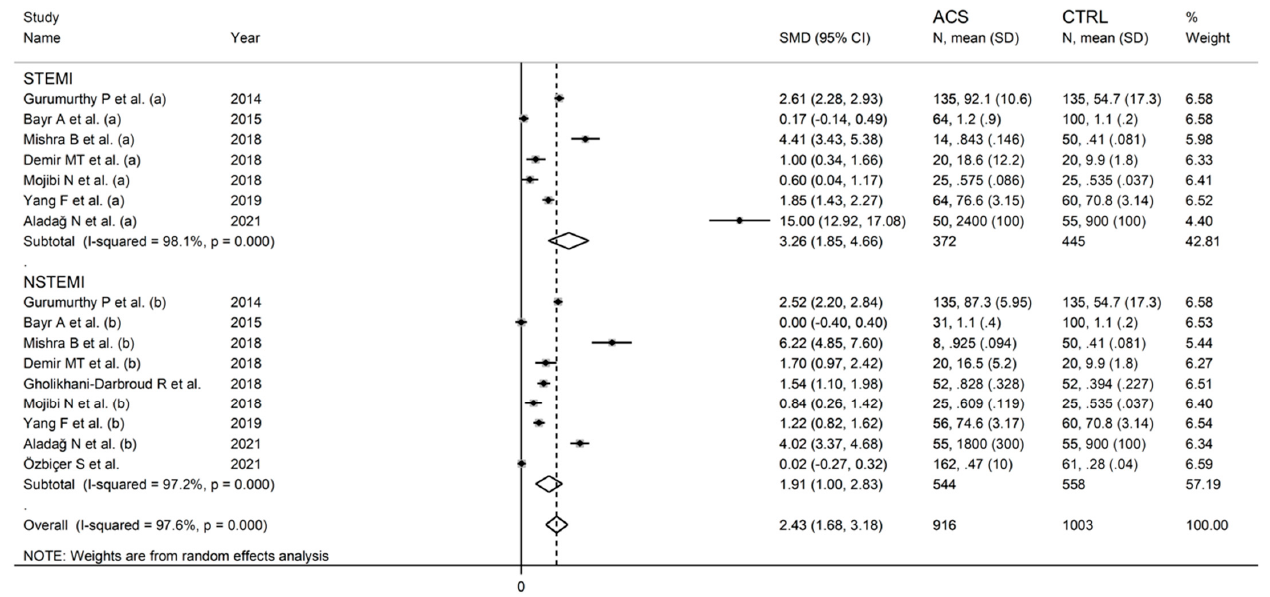
Figure 7. Forest plot of studies examining ischaemia-modified albumin in ST-elevation or non-ST- elevation myocardial infarction vs. controls.